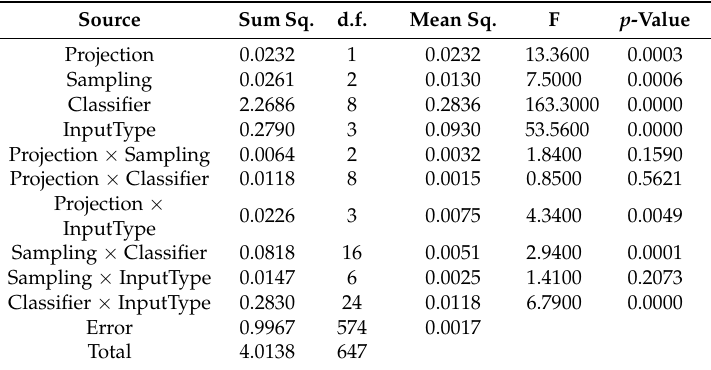
Table 4. ANOVA outcomes.